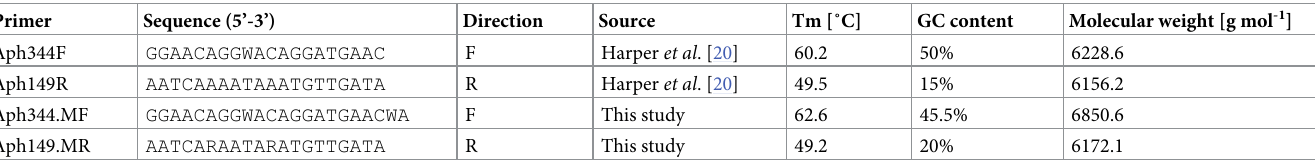
Table 1. Primers designed by Harper et al . [20] compared with those modified for this study. Primer Sequence